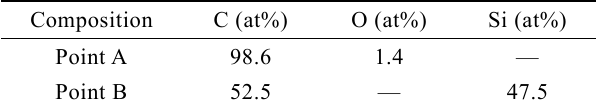
Table 3 Quantitative EDX analysis result of the wear scar of the ball after friction in NDP–OH (1 wt%). Points A and B are shown in Fig. 9(a).